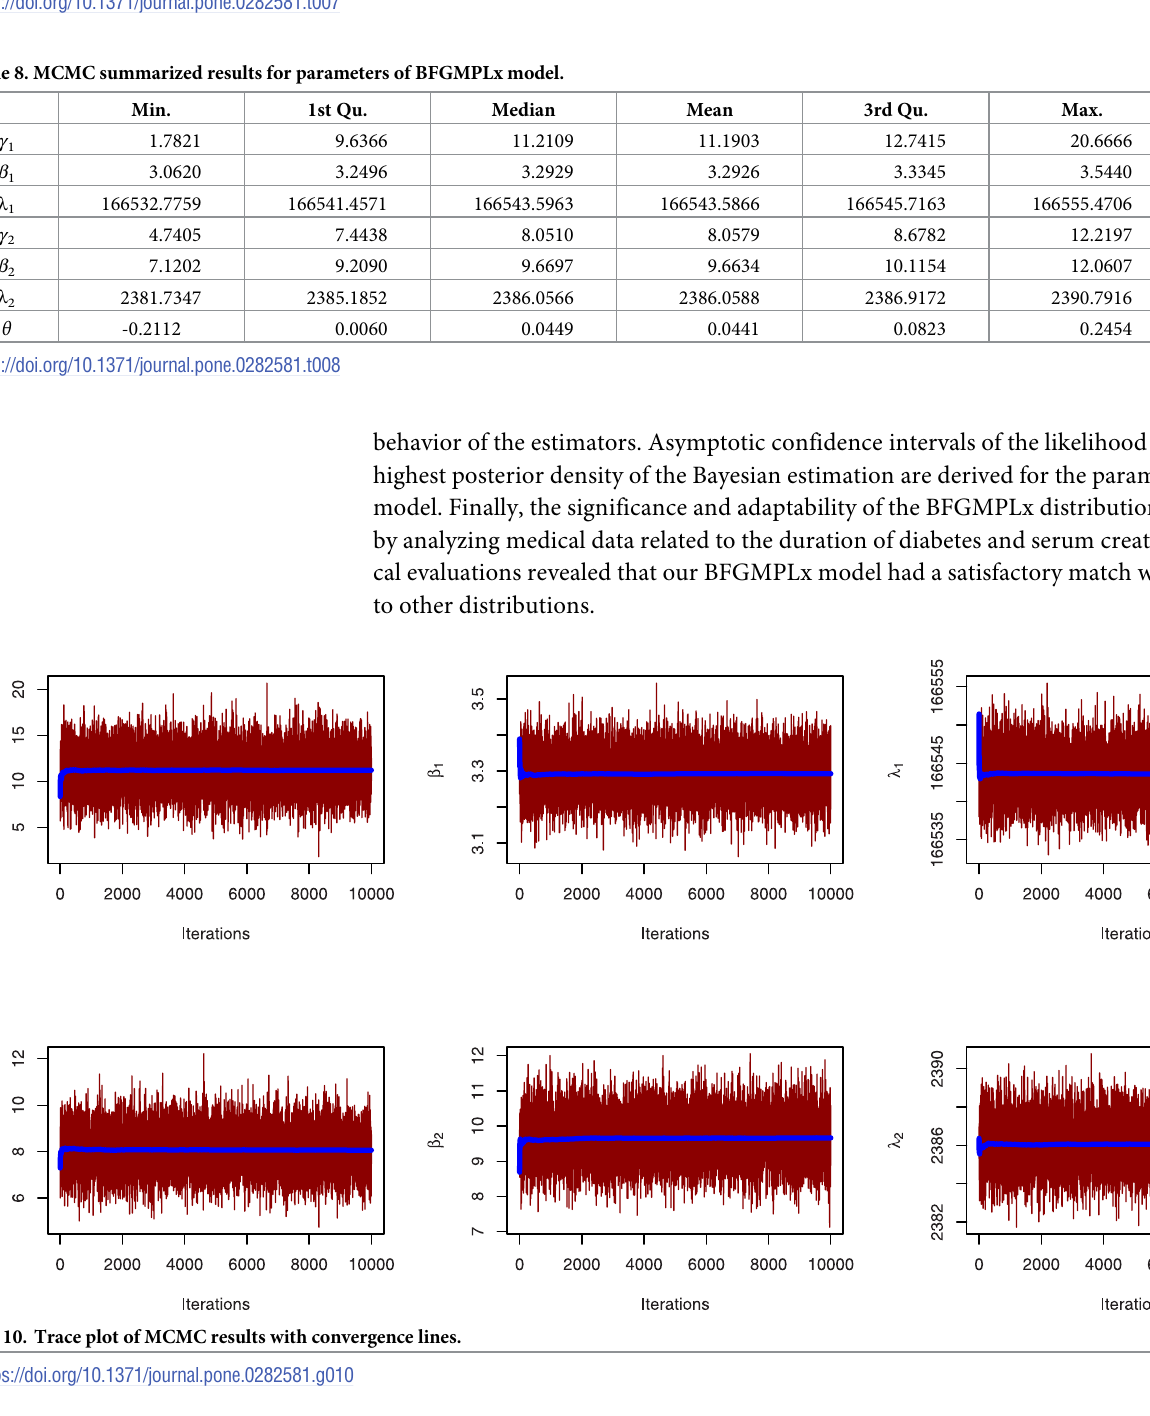
Fig 10. Trace plot of MCMC results with convergence